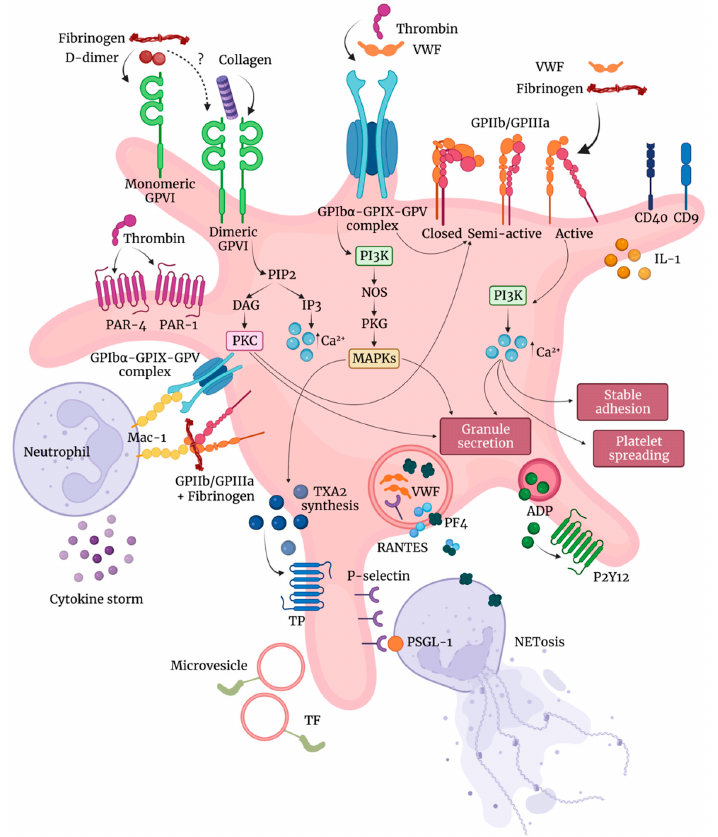
Figure 1. Platelet activation in COVID-19. Platelets from COVID-19 patients show higher expression of the GPIb α –GPIX–GPV complex, GPIIb/GPIIIa complex, CD9, and CD40. Activated platelets also show increased secretion of IL-1 and release of microvesicles–TF (tissue factor) complexes. While fibrinogen and D-dimer bind to monomeric GPVI, collagen binds to dimeric GPVI, leading to the activation of PKC (protein kinase C). Thrombin and VWF (von Willebrand factor) bind to the GPIb α –GPIX–GPV complex, leading to the activation of PI3K/MAPKs and to a conformational change of the GPIIb/GPIIIa complex in its active form, able to bind fibrinogen and VWF and to activate PI3K, leading to an increase in the intracellular Ca 2+ . These pathways lead to platelet adhesion, spreading, TXA2 (thromboxane A2) synthesis, and granule secretion of ADP, PF4 (platelet factor 4), VWF, RANTES, and P-selectin. PF4–RANTES heterodimerization and the binding of P-selectin to PSGL-1 (P-selectin glycoprotein ligand 1) stimulate platelet–neutrophil interaction and promote NETs (neutrophil extracellular traps) formation. The binding of GPIb α –GPIX–GPV and GPIIb/GPIIIa ÷ fibrinogen complexes to Mac-1 (macrophage antigen-1) regulates platelet–leukocyte interaction exacerbating the inflammatory